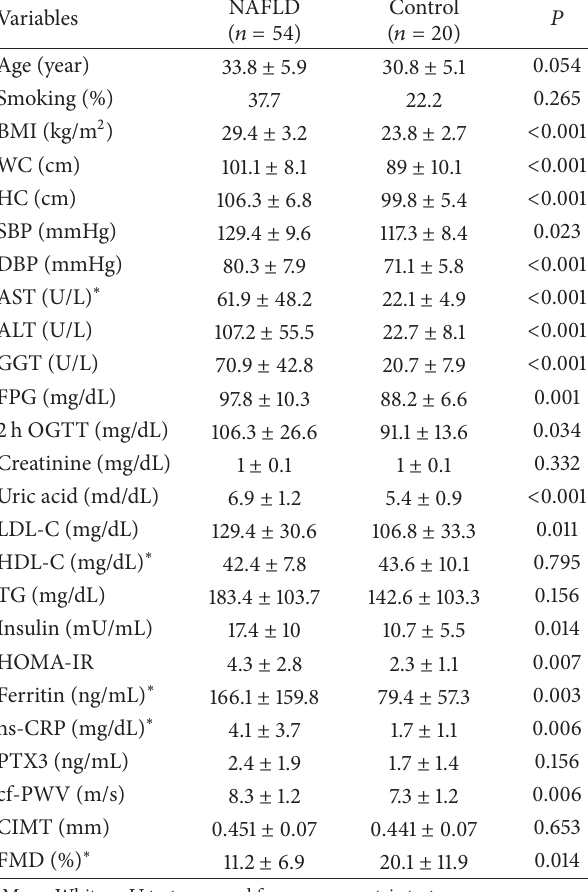
Table 1: Baseline characteristics of study population.